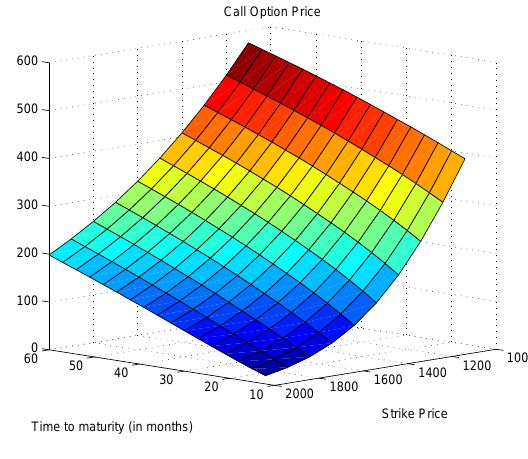
Figure 18. Call options prices.